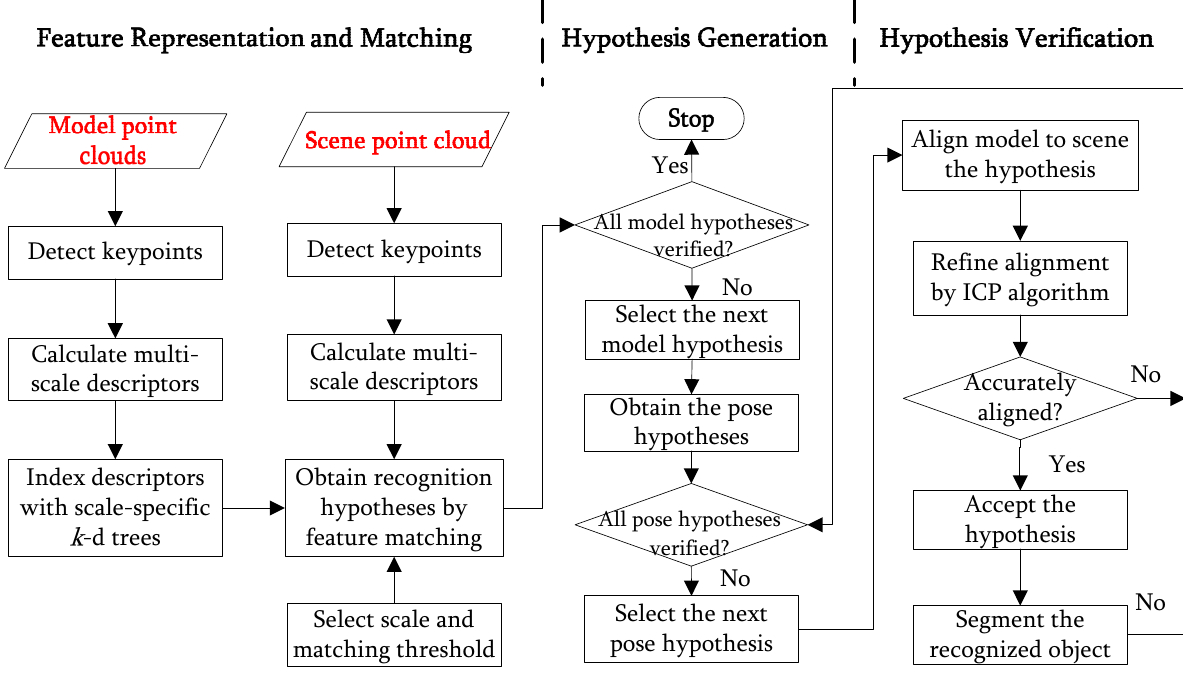
Figure 4. The flowchart of the 3D object recognition